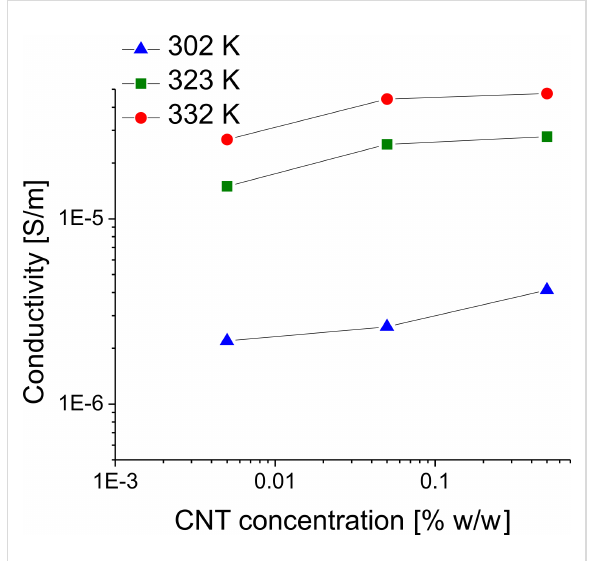
Figure 12: Conductivity as a function of the CNT concentration at three constant temperatures.